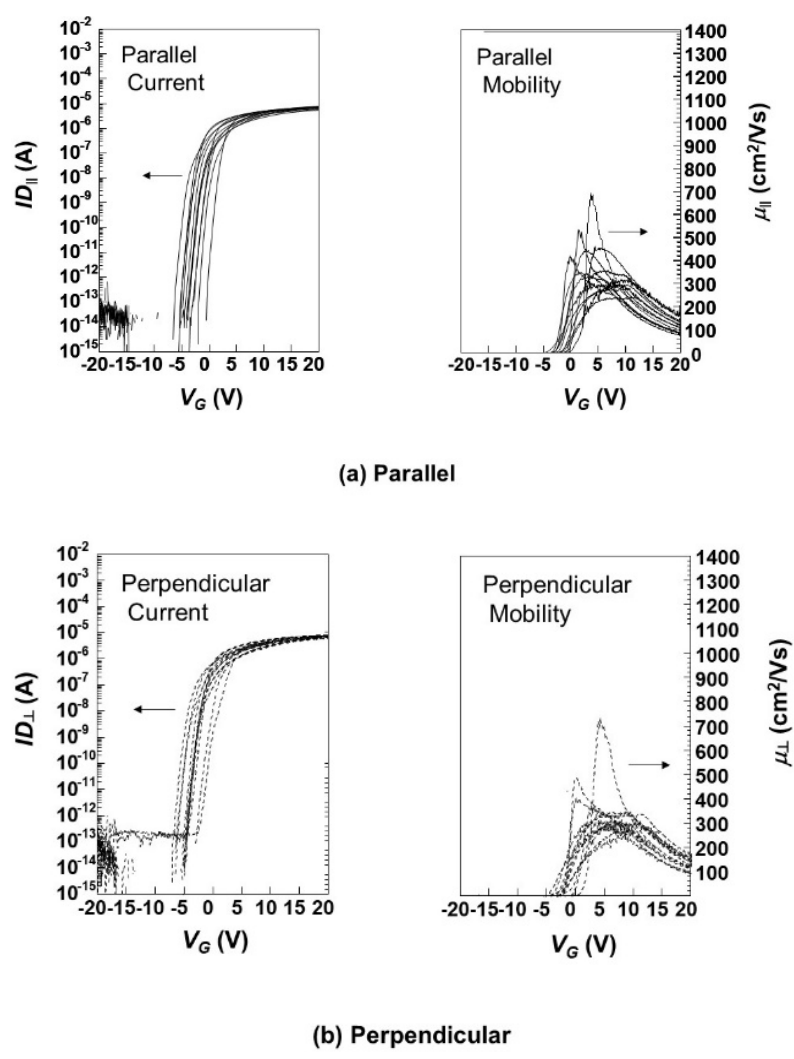
Figure 9. Variations in the characteristics of the drain currents I D and effective mobilities µ on V G in the measured GB-free samples: ( a ) the parallel TFTs and ( b ) the perpendicular TFTs.